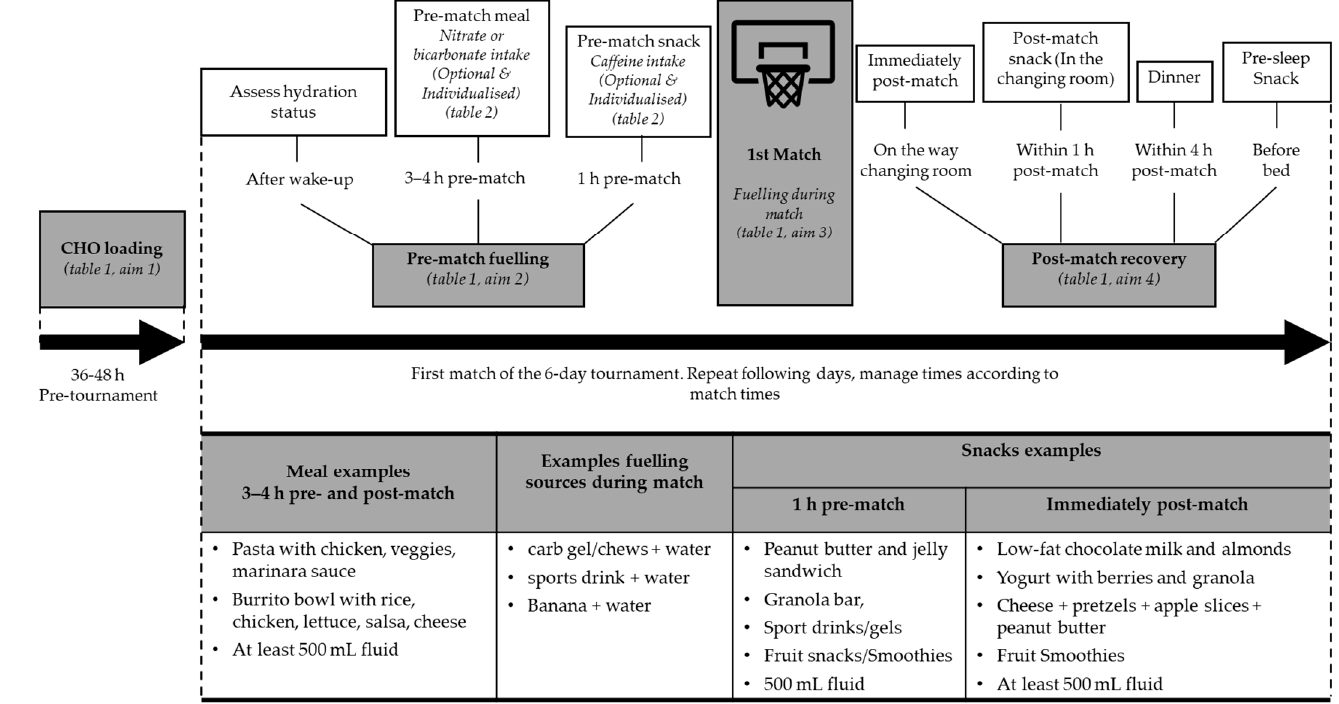
Figure 1. Time guide for optimum nutrition during a typical tournament schedule. Adapted from [16].